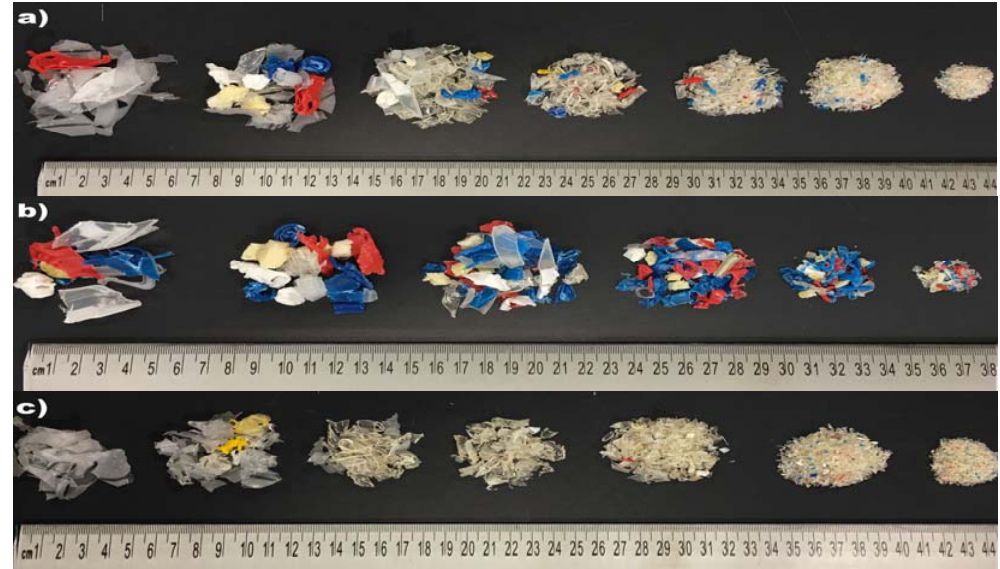
Figure 3. General view of shape and size of the BPW after sieving: ( a ) Hybrid, ( b ) hard, ( c ) soft.